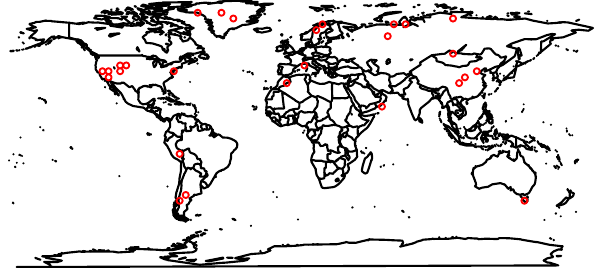
Fig. 4. The 27 proxy locations taken from Juckes et al. (2007) for the present local-scale comparison. Note that the Juckes et al. (2007) set consists of 33 proxy locations, but some locations were so close together that a single representation was chosen for that location. A higher resolution model would likely have allowed a comparison using the full set of